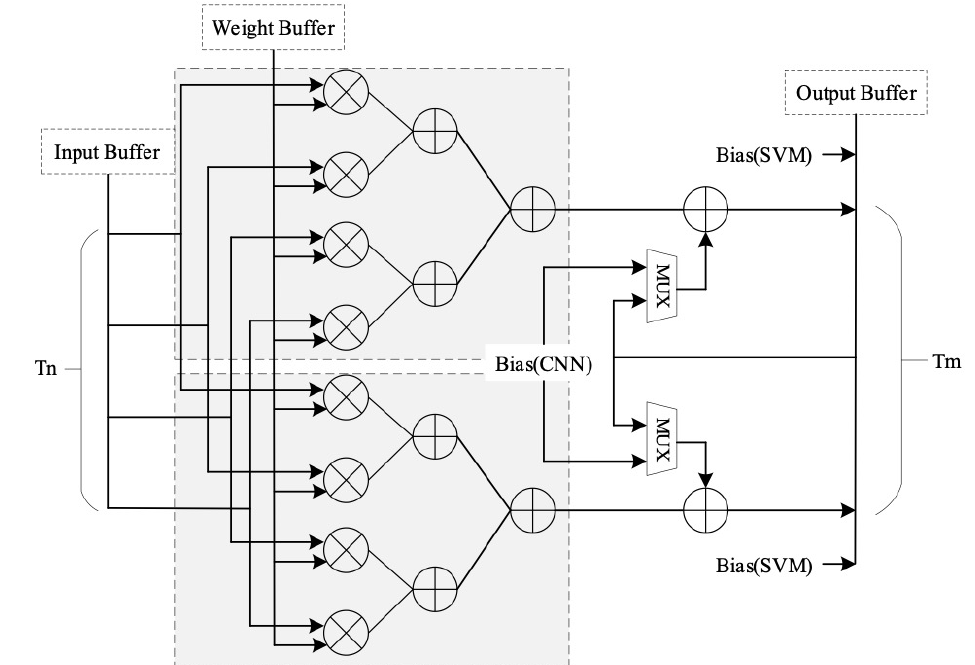
Figure 2. Resource-efficient general